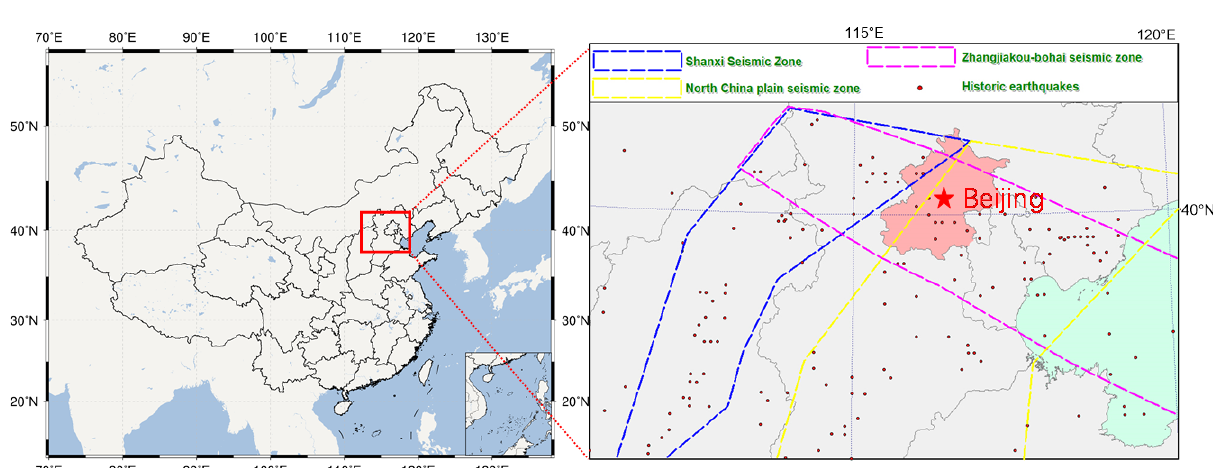
Figure 1. The geological environment and position of